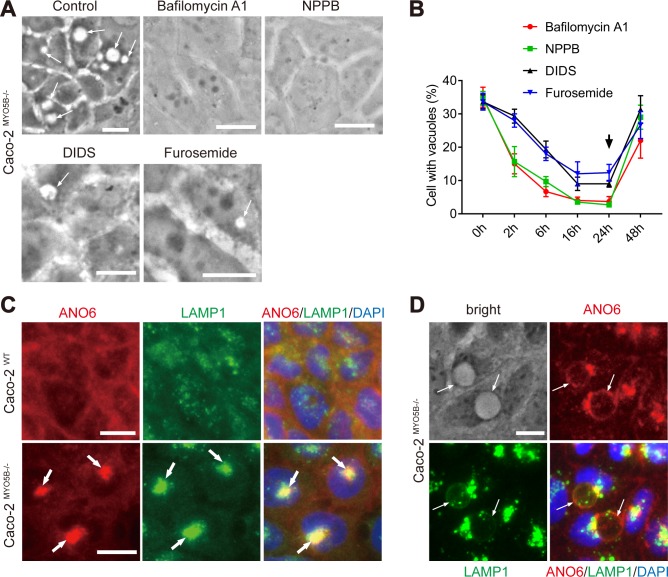
vATPase and chloride channel activities mediate the late endosomal phenotype in Caco2MYO5B−/− cells.(A–B) The numbers of vacuoles in Caco2MYO5B–/–cells were reduced after treatments with vATPase inhibitor BafA1 and chloride channel inhibitors NPPB, DIDS, and furosemide for 24 h (A) and other appropriate times (B). Vacuoles reappeared after washout of the chemicals and culture in normal cell culture medium (B, arrow). Values for each data point can be found in S6 Data. (C–D) Caco2MYO5B−/− cells revealed a shift in the abundance of the chloride channel ANO6 from the cell periphery to LAMP1-positive compartments (C, thick arrows) and vacuoles (D, thin arrows) compared with Caco2WT cells. N = 3 independent experiments. Scale bars: 10 μm. ANO, anoctamin; Baf, bafilomycin; DIDS, 4,4'-Diisothiocyano-2,2'-stilbenedisulfonic acid; LAMP, late endosome–associated membrane protein; NPPB, 5-nitro-2-(3-phenylpropyl-amino) benzoic acid; vATPase, vacuolar H+-adenosine triphosphatase; WT, wild type.